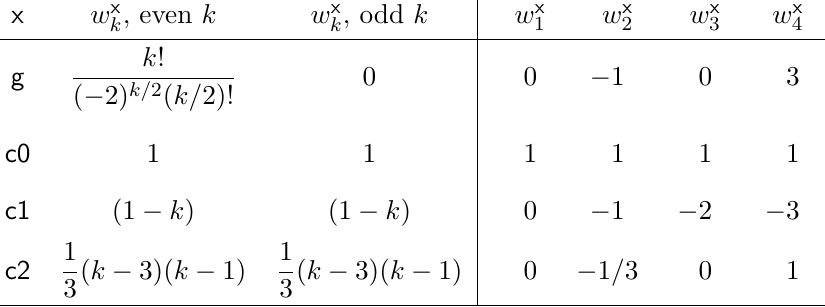
Table 1 . Summary of the kernel-dependent coefficients w x eq. (2.18). Although not reflected in the general formulae, w c1 coefficients with odd k for their respective smearing